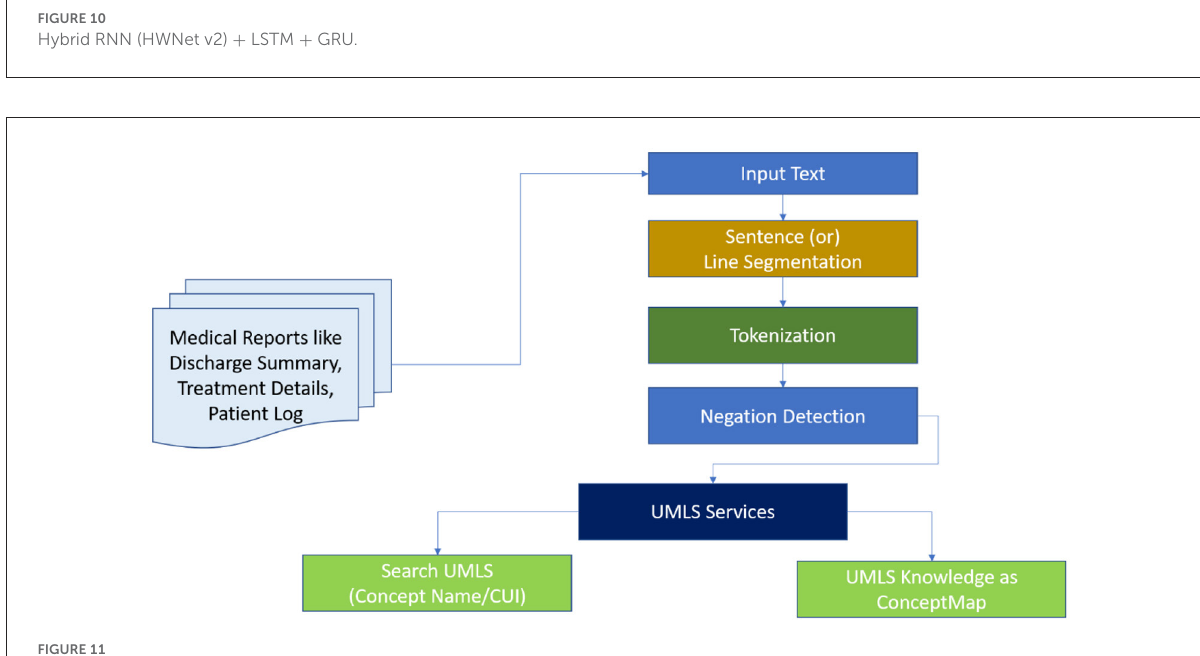
FIGURE11 MetaMap lite procedure.